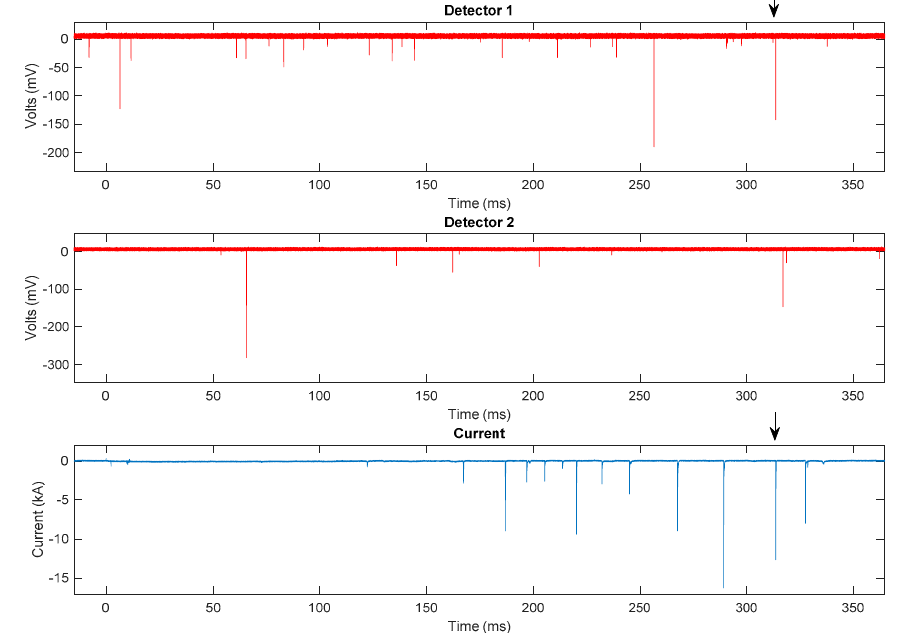
Figure 7. The complete time window of the flash occurred on 02 March, 2015 corresponding to the RS shown in Figure 6. The time t = 0 corresponds to 20:54:37.247308 UTC. The current peak and the X-ray burst shown in Figure 6 are indicated by black vertical arrows.